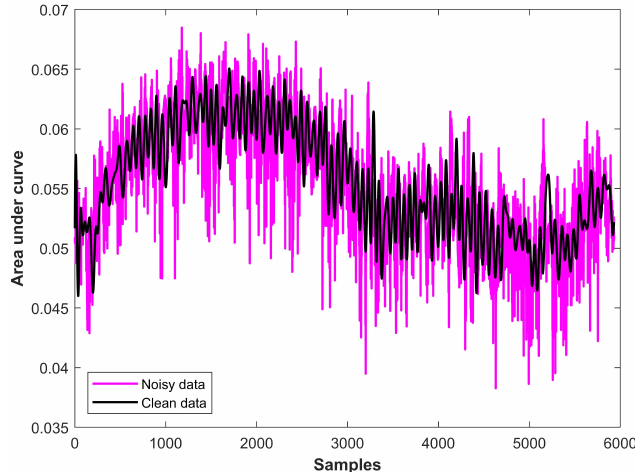
Figure 5. Data preprocessed for RPM